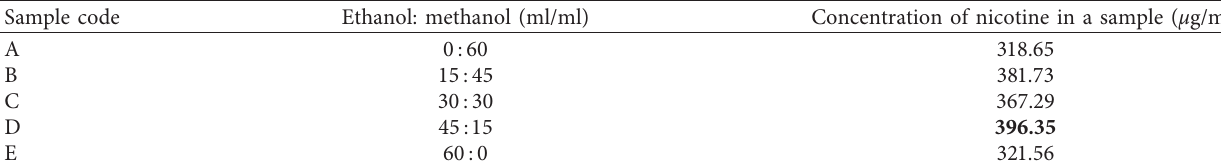
Table 3: Nicotine concentration extracted at different ethanol-to-methanol ratios.